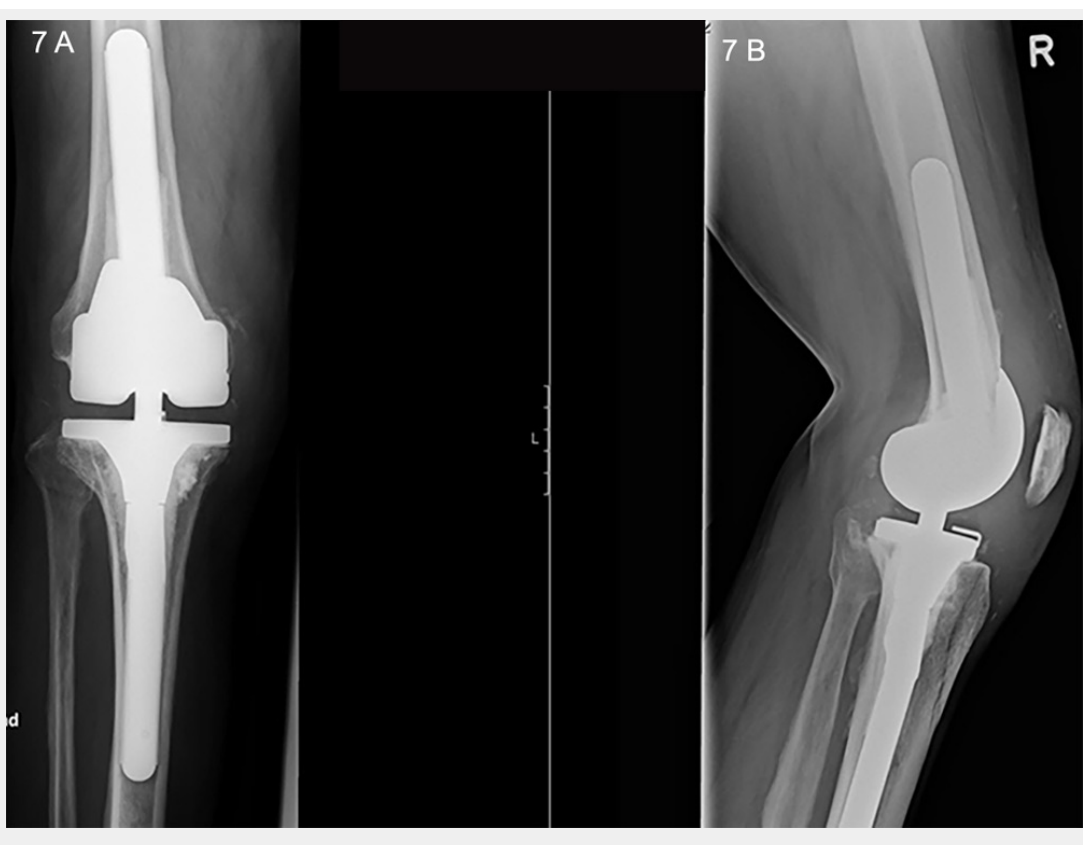
Figure 7 A. Anteroposterior X-ray of an hinged revision prosthesis. B. Lateral view in the same